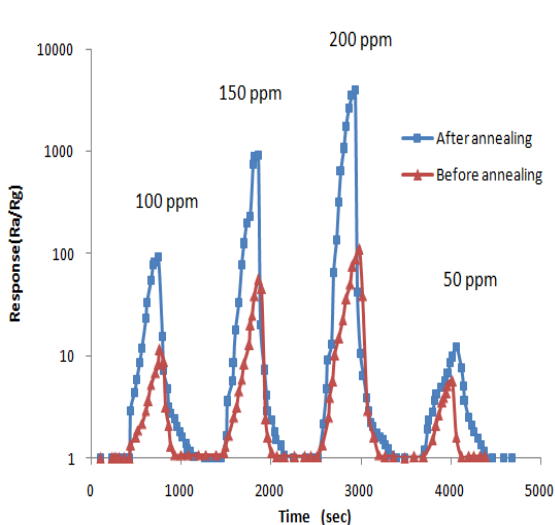
Fig.7: The response of ZnO gas sensors (annealed and as received ) to different H concentration at operation temperature (350 o C for annealed and 400 o C ).